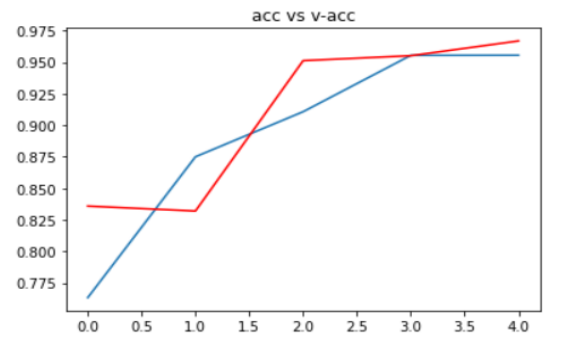
Figure 4.5: Simulation